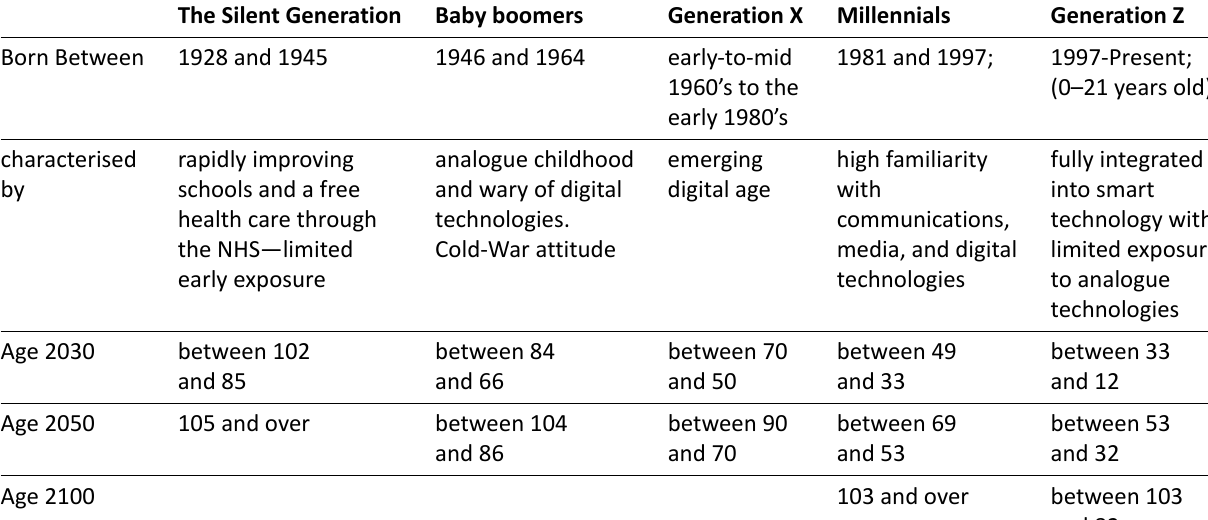
Table 1. Generation timeline: 1928–2100, alongside characteristics for current